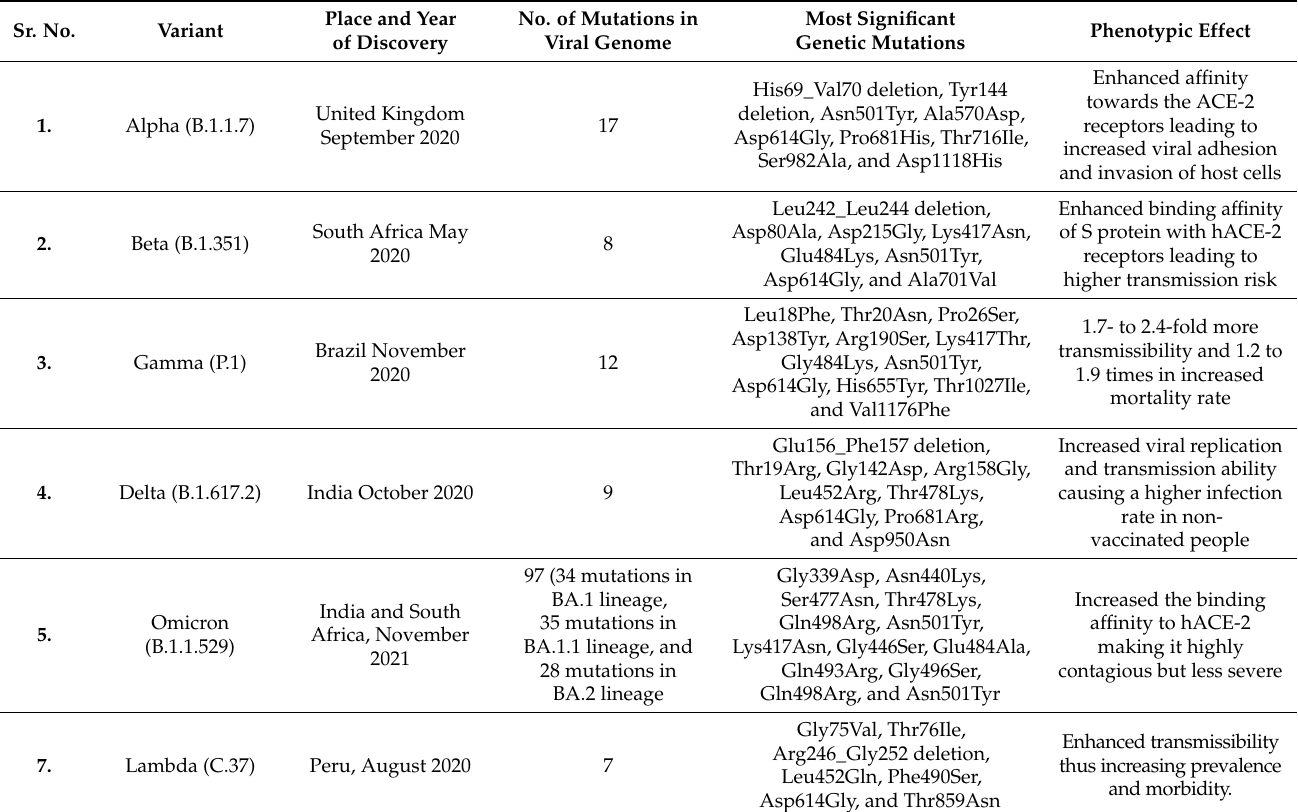
Table 3. Mutations associated with SARS-CoV-2